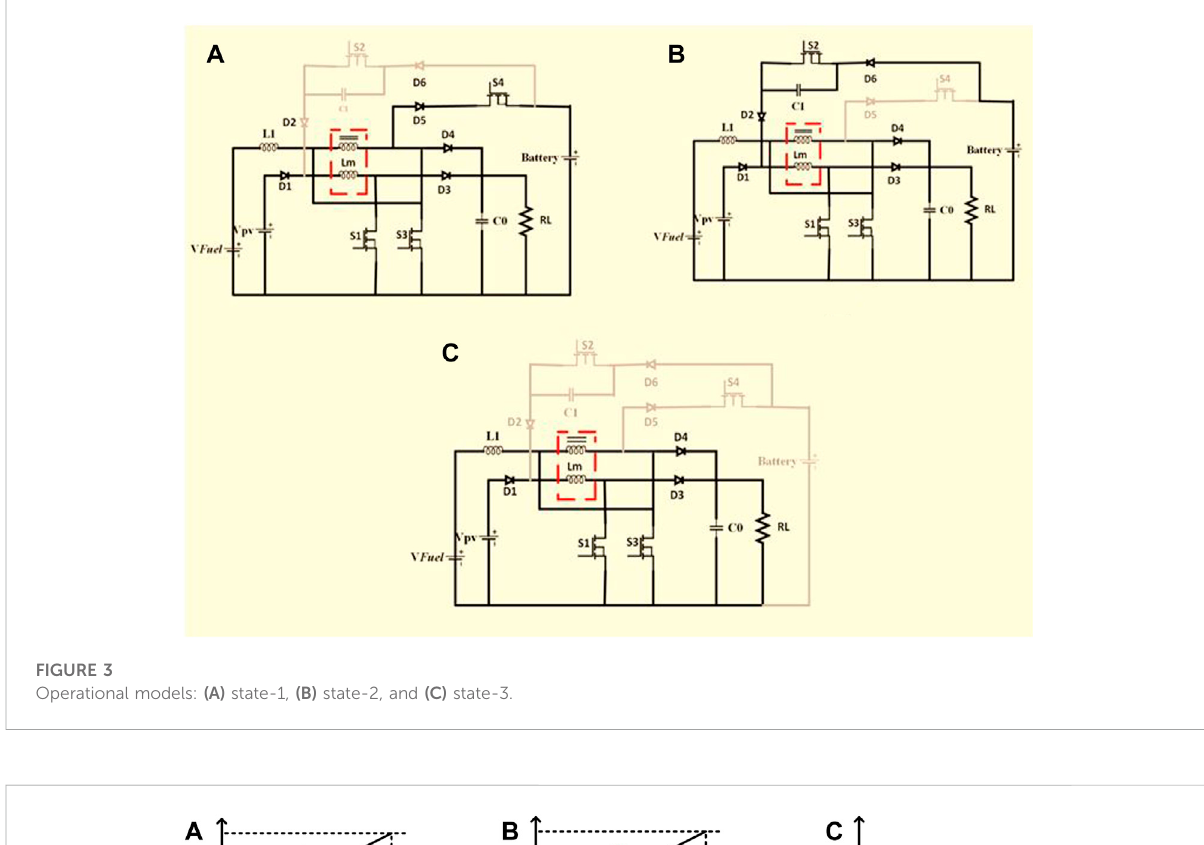
FIGURE 3 Operational models: (A) state-1, (B) state-2, and (C) state-3.